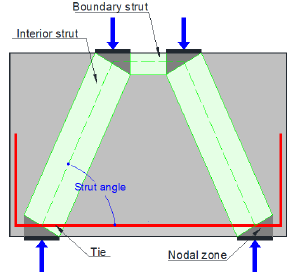
Figure 23: Description of